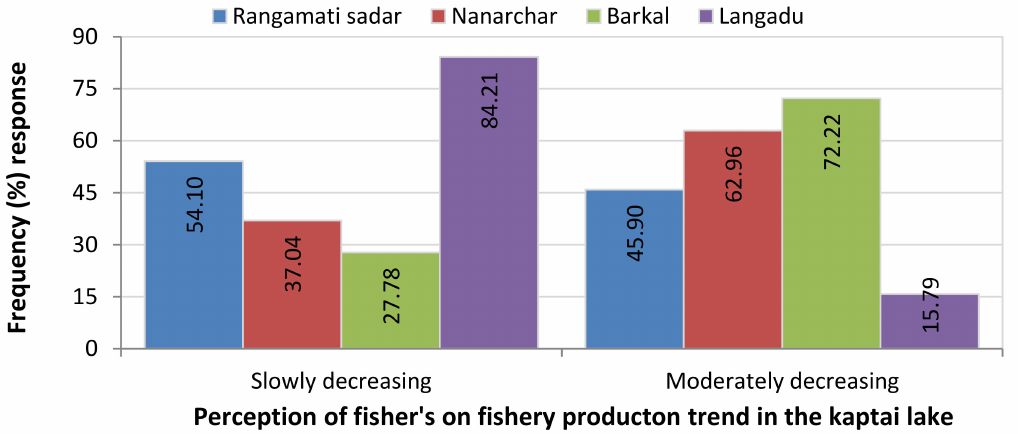
Figure 8. Fishers’ perceptions of the fishery production trend in Kaptai